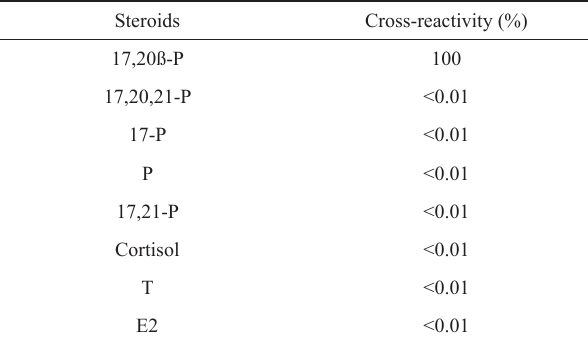
Table 3. Cross-reactivity of steroids with the anti- 17,20β-P used for radioimmunoassay. Cross-reactivity was determined by comparing the concentrations of unlabeled cortisol and unlabeled competitors for the displacement of 50% of the antibody-bound